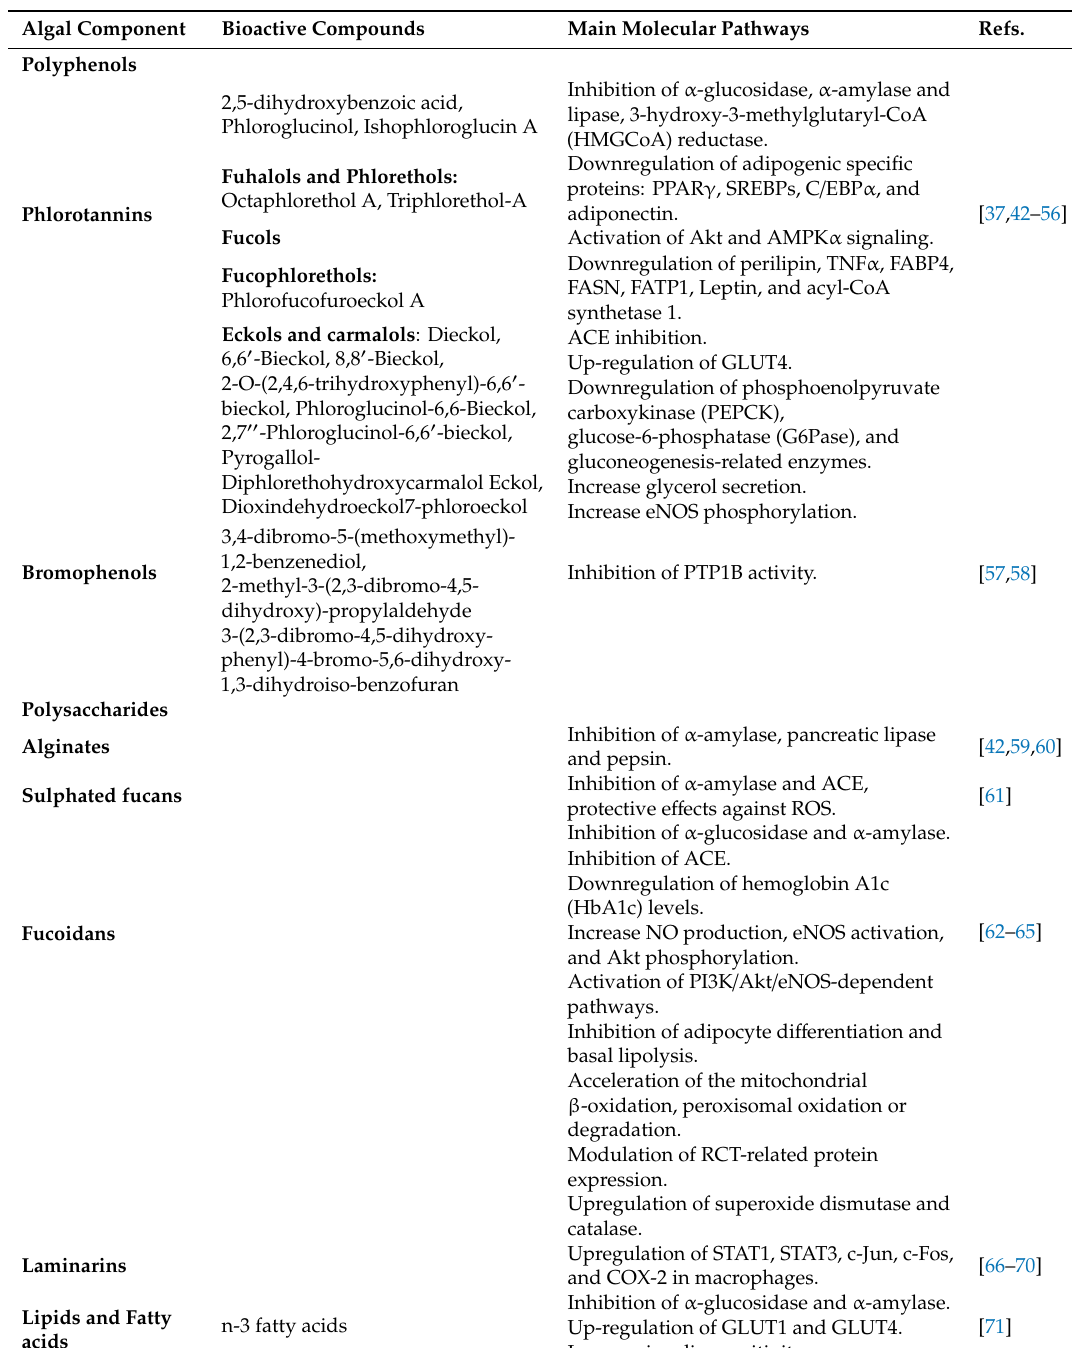
Table 2. Principal classes of brown seaweed compounds and metabolites with their relative biological e ff ects in the context of MS